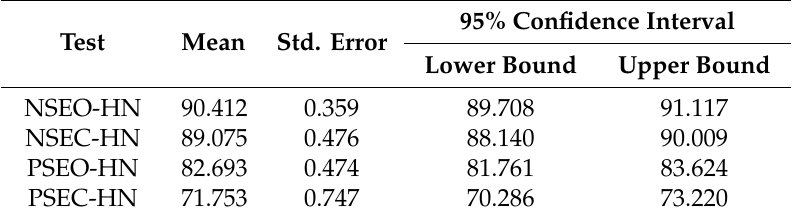
Table 6. Concussion patients’ postural stability scores head neutral mCTSIB.